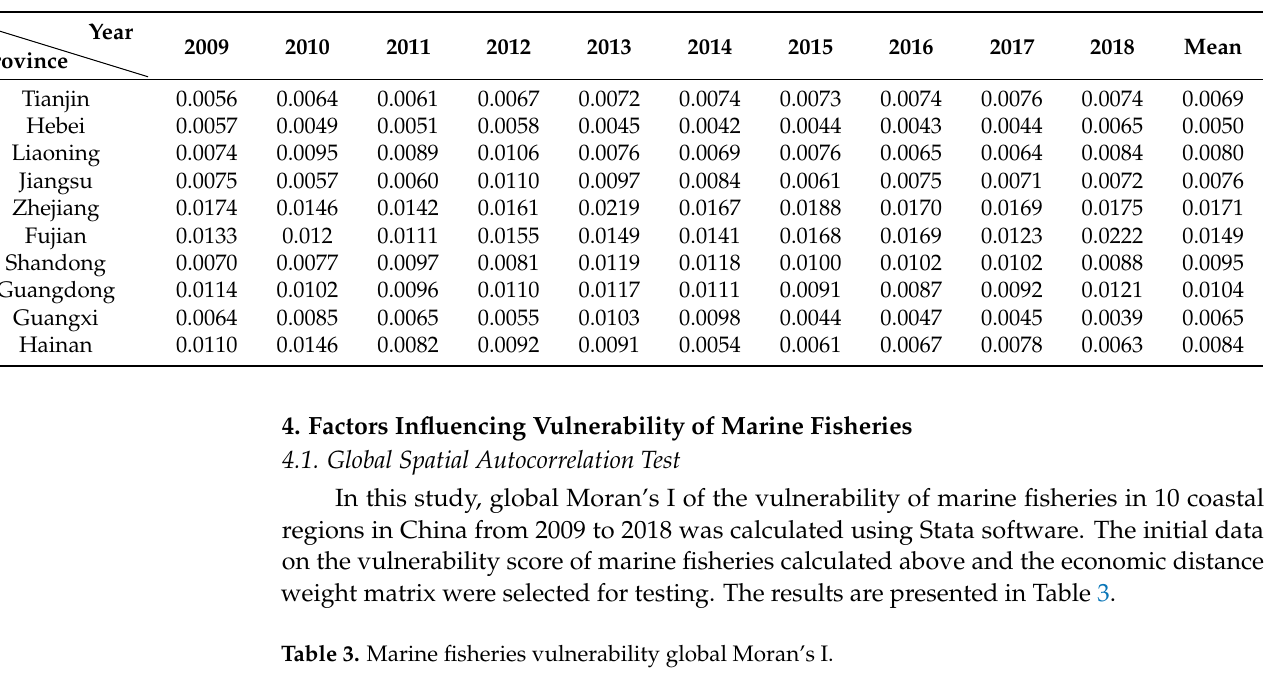
Table 2. Extent of vulnerability of marine fisheries in the coastal regions of China.